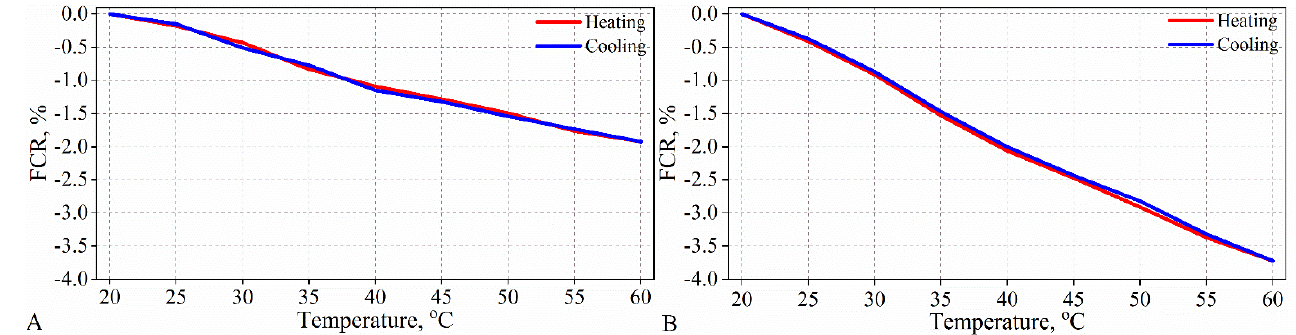
Figure 11. Fractional change in resistivity with temperature during heating and cooling for compo- sites with graphite content: ( A ) 2 wt% and ( B ) 3 wt%.